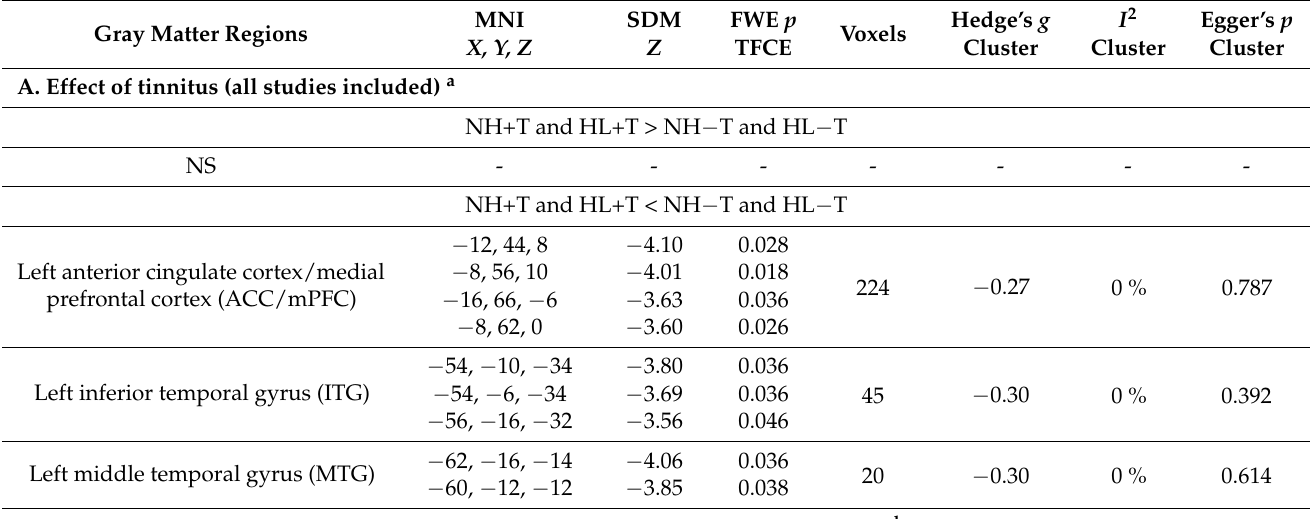
Table 2. Whole-brain meta-analyses of studies comparing individuals with and without